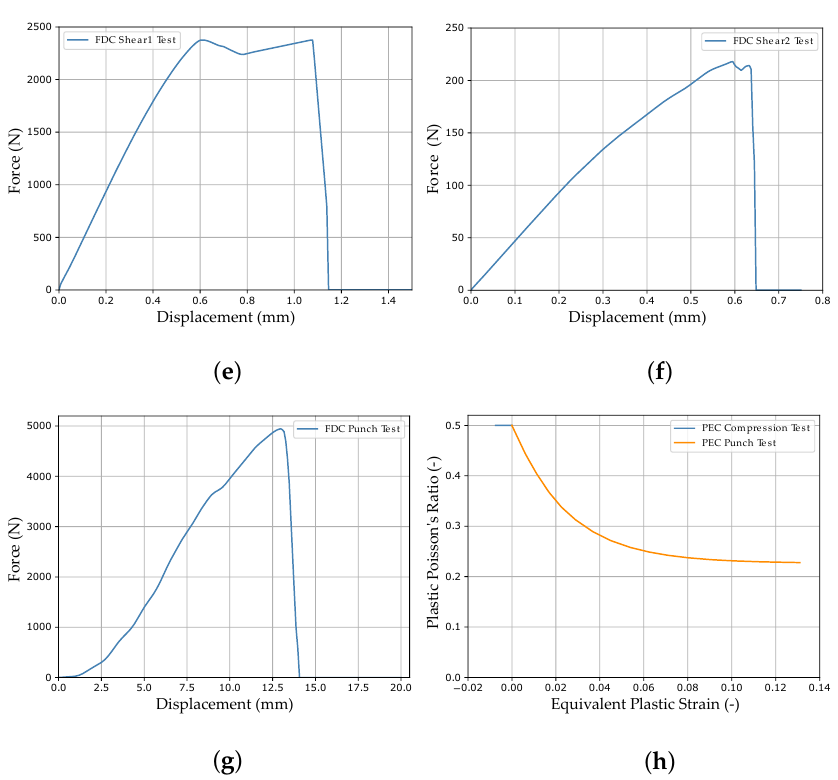
Figure A1. Simulation output curves of the virtual experimental test dataset: ( a ) FDC tension test; ( b ) FDC compression test; ( c ) FDC tension tests V1–V4; ( d ) FDC bending test; ( e ) FDC shear1 test; ( f ) FDC shear2 test; ( g ) FDC punch test; and ( h ) PEC compression and punch test.